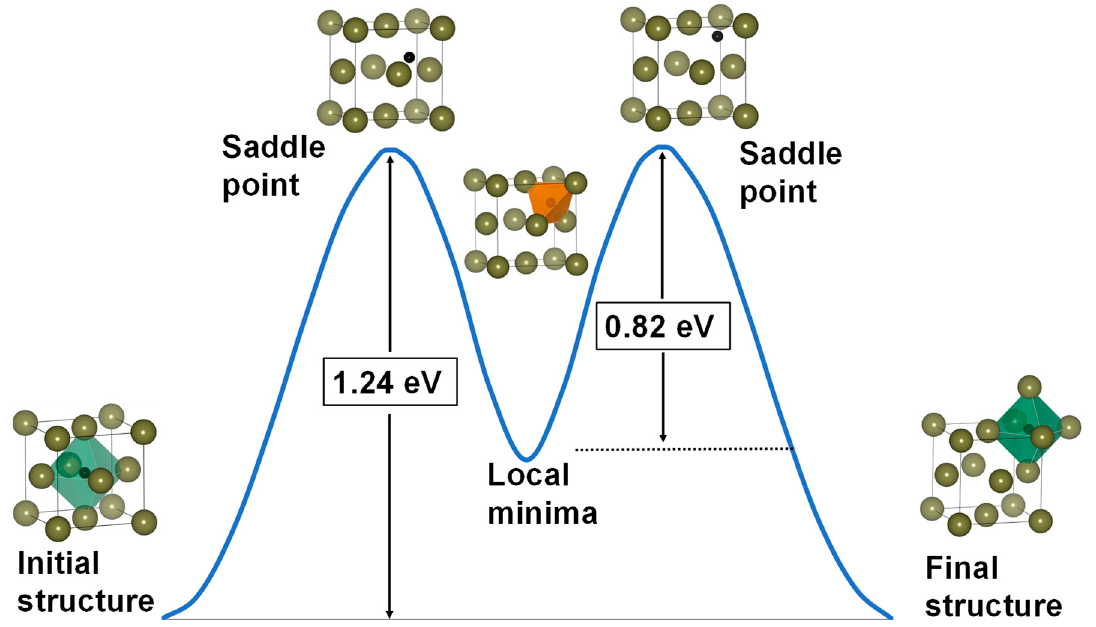
Figure 4. The predicted diffusion pathway of C in the Pb matrix from an initial octahedral position, to an intermediate tetrahedral position, to a final octahedral position, i.e., 𝐶 (cid:3036)(cid:3016)(cid:3030)(cid:3047)(cid:3028) → 𝐶 (cid:3036)(cid:3021)(cid:3032)(cid:3047)(cid:3045)(cid:3028) → 𝐶 (cid:3036)(cid:3016)(cid:3030)(cid:3047)(cid:3028) .